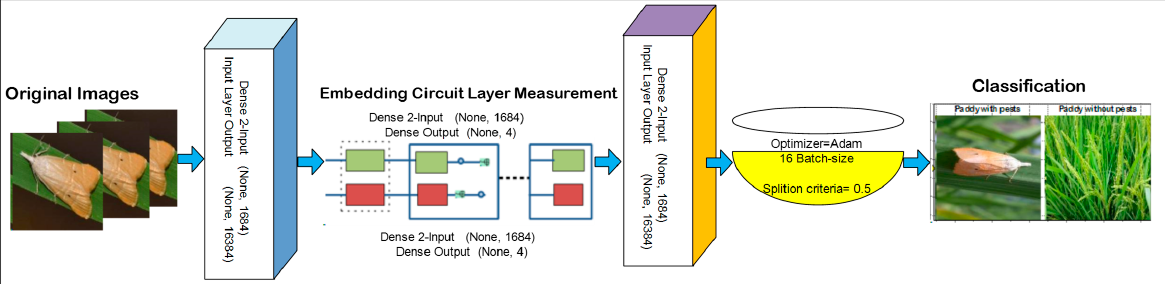
Figure 3. A proposed quantum model for